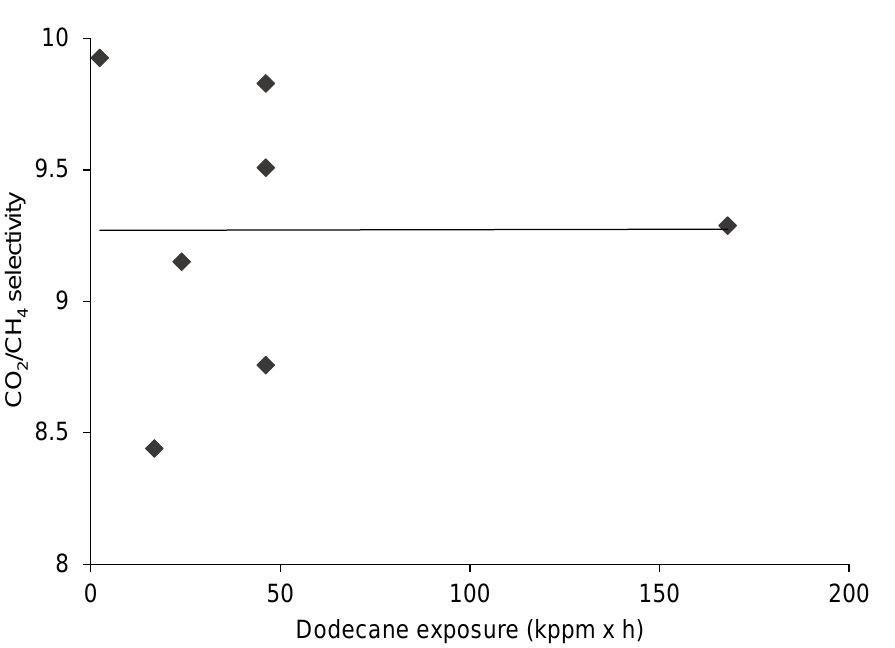
Figure 8. The e ff ect of dodecane exposure on CO 2 / CH 4 Figure 8. The effect of dodecane exposure on CO 2 /CH 4 selectivity. Figure 8. The effect of dodecane exposure on CO 2 /CH 4 selectivity.